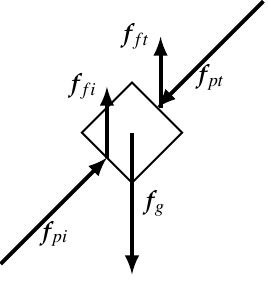
Figure 2. Force diagram of an stationary unknown load configuration grasped by the index finger and thumb. The index finger and thumb apply a pinching force indicated by f p compensates for the gravity f g force acting on the load’s